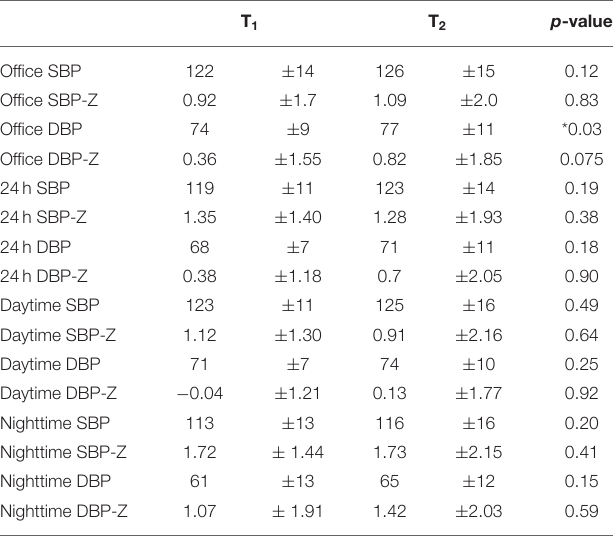
TABLE 4A | Blood pressure data at T 1 and T 2 .